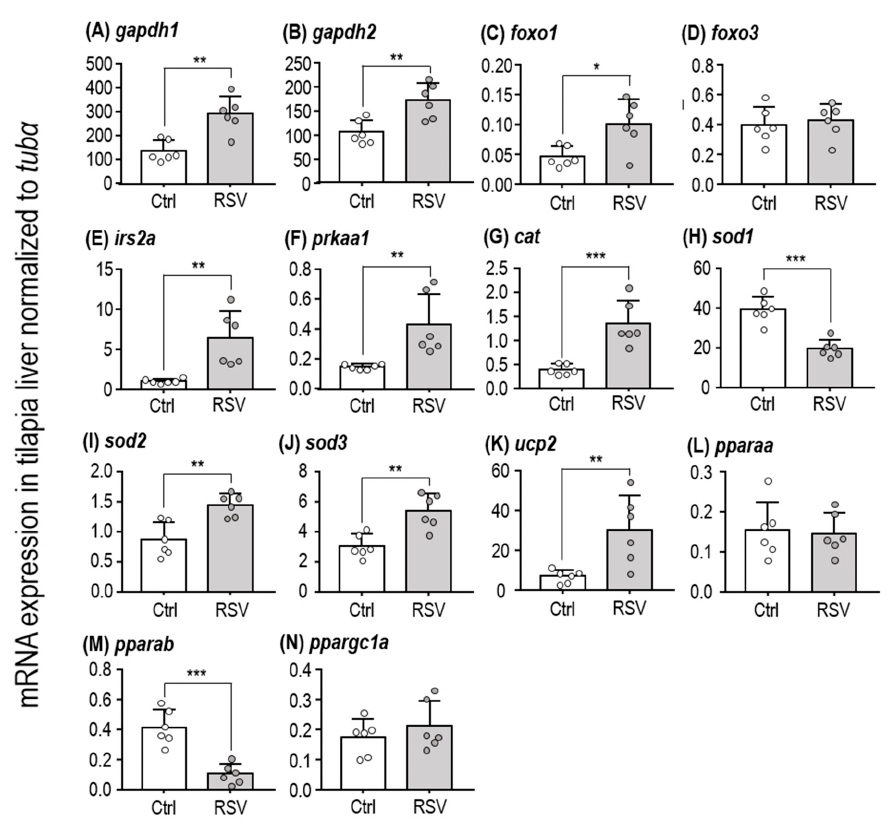
Figure 2. Relative expression levels of SIRT-related homologues in the liver of tilapia fed with the Ctrl and RSV-diet for three days. qPCR analysis was used to compare liver expression levels of gapdh1 ( A ), gapdh2 ( B ), foxo1 ( C ), foxo3 ( D ), irs2a ( E ), prkaa1 ( F ), cat ( G ), sod1 ( H ), sod2 ( I ), sod3 ( J ), ucp2 ( K ), pparaa ( L ), pparab ( M ), and ppargc1a ( N ) between juvenile tilapia fed with Ctrl and RSV-diets. The tubulin alpha chain ( tub α ) was used as a reference gene. White dots and columns indicate the Ctrl group. Gray dots and columns indicate the RSV group. Data are presented as mean ± SD ( n = 6). Asterisks indicate significant difference (* p < 0.05, ** p < 0.01, *** p < 0.001) between Ctrl and RSV groups.